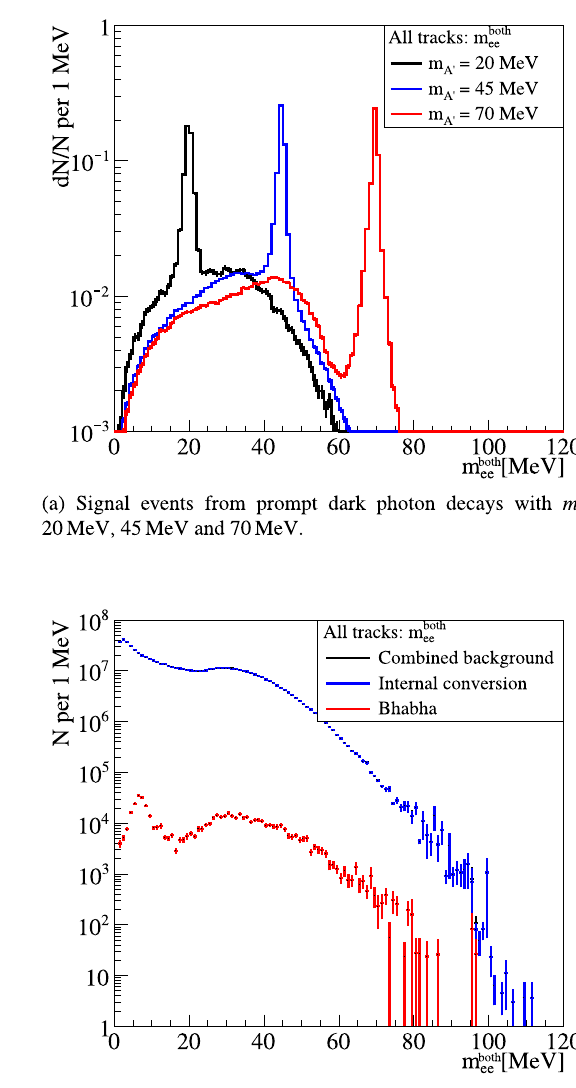
exclusively to an e + e − pair. A comparison with current limits from dark photon searches is shown in Fig. 43a.